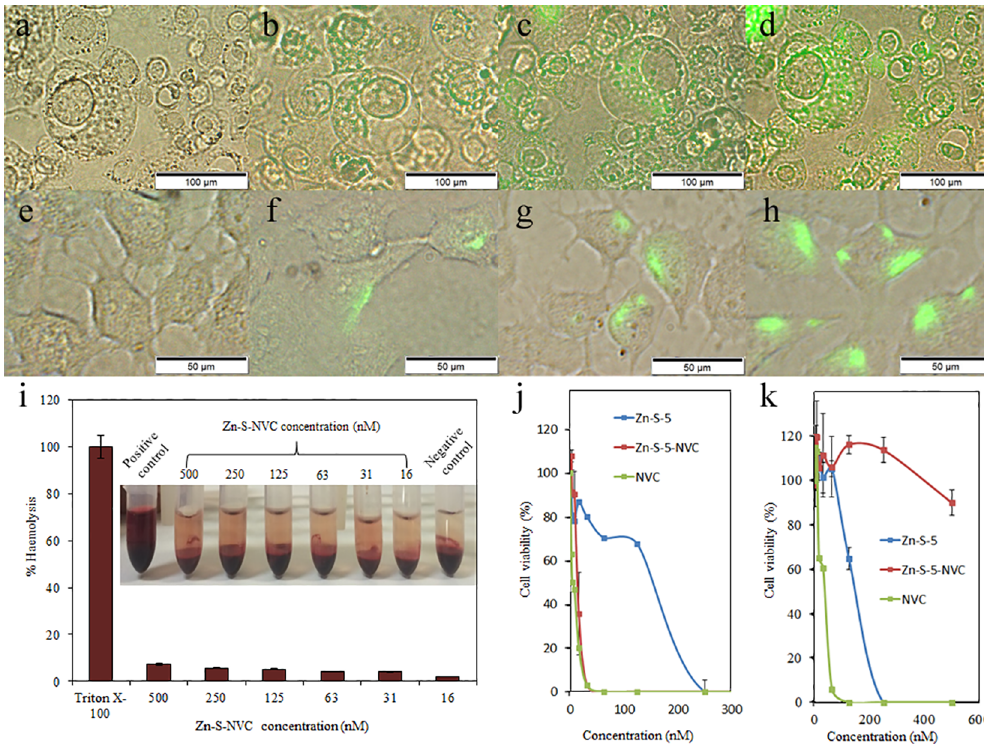
Fig 4. Fluorescence microscopy images. A) PC3 cells exposed to Zn-S-NVC (conjugated to fluorescent dye) at 0 min. B) PC3 cells exposed to Zn-S-NVC (conjugated to fluorescent dye) at 30 min. C) PC3 cells exposed to Zn-S-NVC (conjugated to fluorescent dye) at 60 min. D) PC3 cells exposed to Zn-S-NVC (conjugated to fluorescent dye) at 90 min. E) PNT1A cells exposed to Zn-S-NVC (conjugated to fluorescent dye) at 0 min. F) PNT1A cells exposed to Zn-S-NVC (conjugated to fluorescent dye) at 30 min. G) PNT1A cells exposed to Zn-S-NVC (conjugated to fluorescent dye) at 60 min. H) PNT1A cells exposed to Zn-S-NVC (conjugated to fluorescent dye) at 90 min. I) Haemocompatibility of Zn-S-NVC using human RBCs, showing negligible haemolytic activity in the selected concentration range of Zn-S-NVC (16–500 nM). Inserts show images after incubation and centrifugation. J) MTT analysis of the PC3 cell line. K) MTT analysis of the PNT1A cell line.